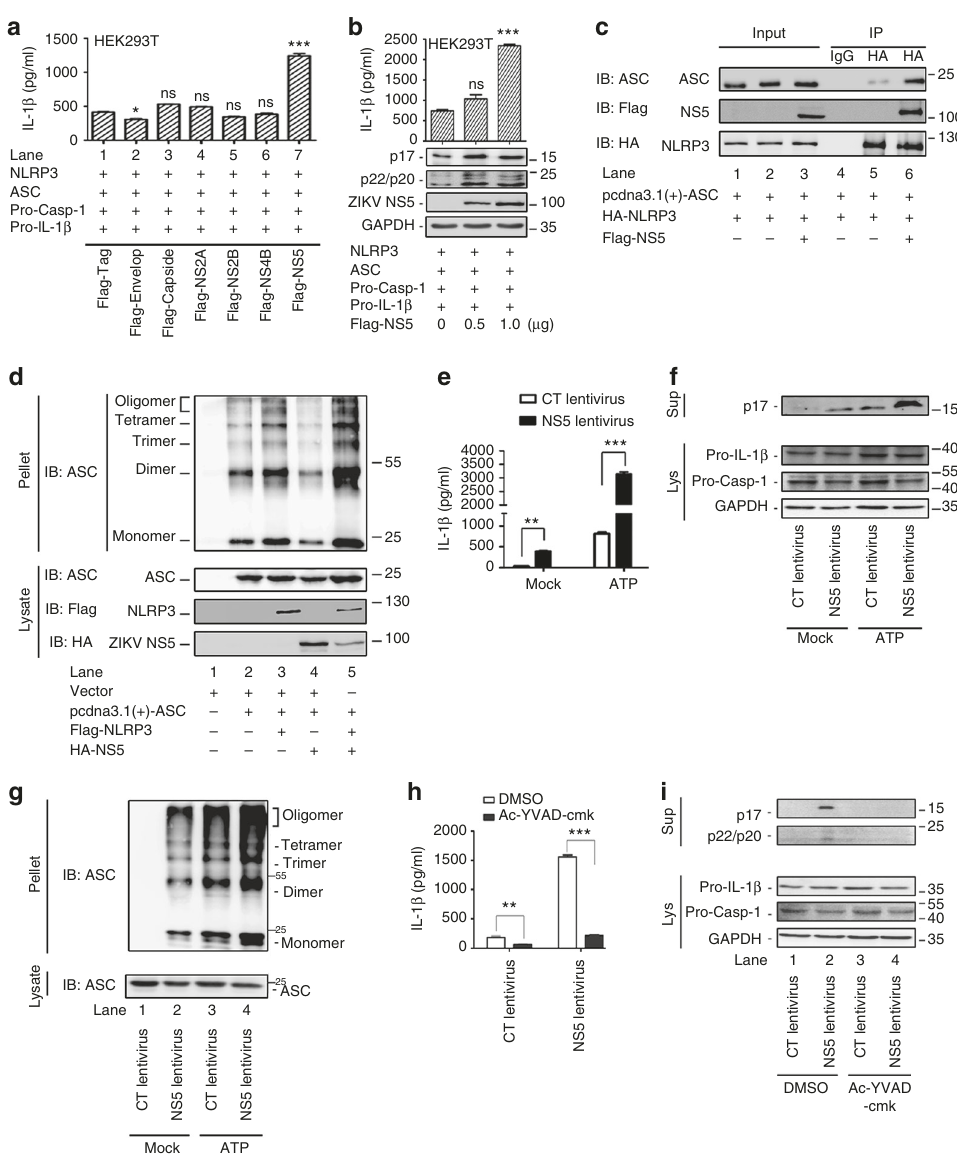
Fig. 4 The role of ZIKV NS5 in the activation of the NLRP3 in fl ammasome. a , b HEK293T cells were co-transfected with plasmids encoding NLRP3, ASC, pro-Casp1, and pro-IL-1 β . The cells were then transfected with pFlag-Env, pFlag-Capsid, pFlag-NS2A, pFlag-NS2B, pFlag-NS4B, or pFlag-NS5 ( a ) or transfected with pFlag-NS5 ( b ). IL-1 β levels in the supernatants were determined by ELISA ( a , b , top). The mature IL-1 β , cleaved pro-Casp-1, ZIKV NS5, and GAPDH levels in the cell lysates were determined by western blot ( b , bottom). c HEK293T cells were co-transfected with pcdna3.1(+)-ASC, pHA-NLRP3, or pFlag-NS5. Cell lysates were subjected to western blots (input) or IP using an IgG or anti-HA antibody and analyzed using immunoblotting with anti-HA, anti-ASC, or anti-Flag antibodies (IP). d HEK293T cells were co-transfected with pcdna3.1(+)-ASC, Flag-NLRP3 or HA-NS5 for 24 h. Cell lysates were prepared and the pellets were subjected to ASC oligomerization assays (top) or western blots (bottom). e – g THP-1 cells were infected with CT-lentivirus or NS5-lentivirus (NS5-encoding lentivirus), which were differentiated into macrophages by stimulating with TPA and then treated with 5 mM ATP for 2 h. IL- 1 β levels in the supernatants were determined by ELISA ( e ). p17 in the supernatants and pro-IL-1 β , pro-Casp-1, and GAPDH in the cell lysates (Lys) were determined by western blot ( f ). Cell pellets were prepared and subjected to ASC oligomerization assays ( g , top). ASC in the cell lysates was determined by western blot ( g , bottom). h , i THP-1 cells were infected with CT-lentivirus or NS5-lentivirus, which were differentiated into macrophages by stimulating with TPA and then treated with caspase-1 inhibitor Ac-YVAD-cmk for 1 h. IL-1 β levels in the supernatants were determined by ELISA ( h ). p17 in the supernatants and pro-IL-1 β , pro-Casp-1, and GAPDH in the cell lysates (Lys) were determined by western blot ( i ). The number of replicates is two. Data shown are means ± s.e.m; * P < 0.05, ** P < 0.01, *** P < 0.0001; ns, no signi fi cance (one-way ANOVA with Tukey ’ s post-hoc test)